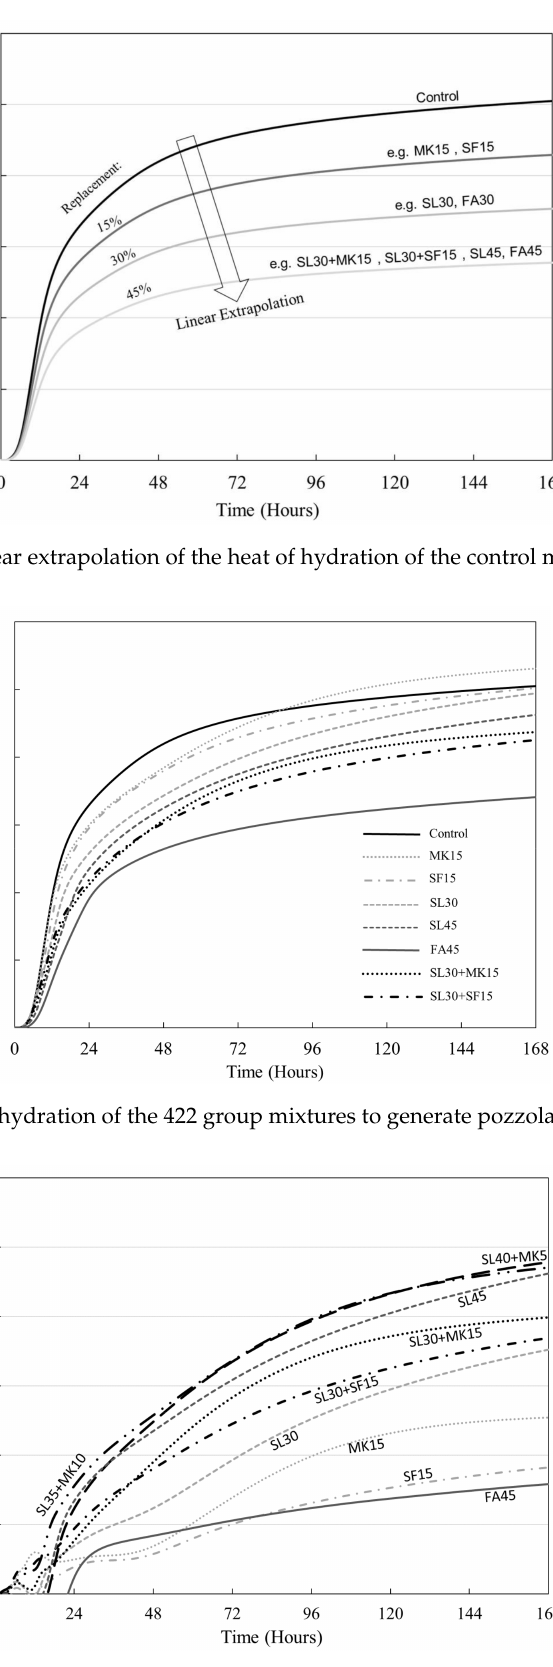
Figure 11. Heat of hydration generated from the pozzolanic